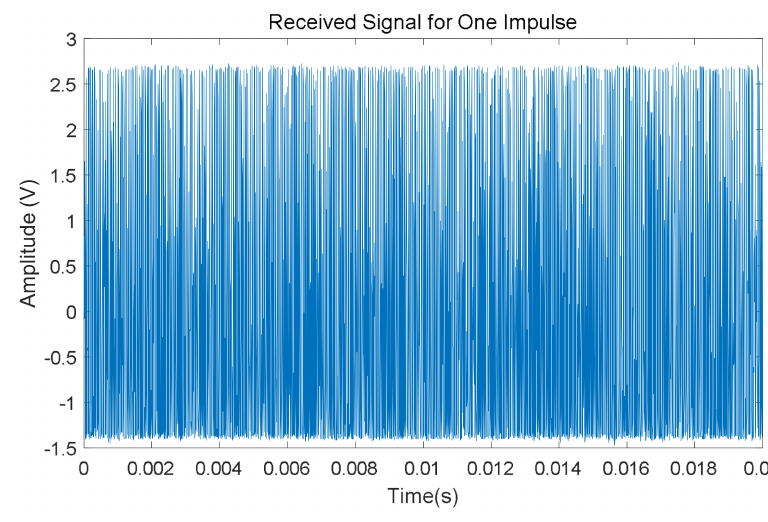
Figure 9. Example of a train of UGW pulses masked under noise for an occupied track section.